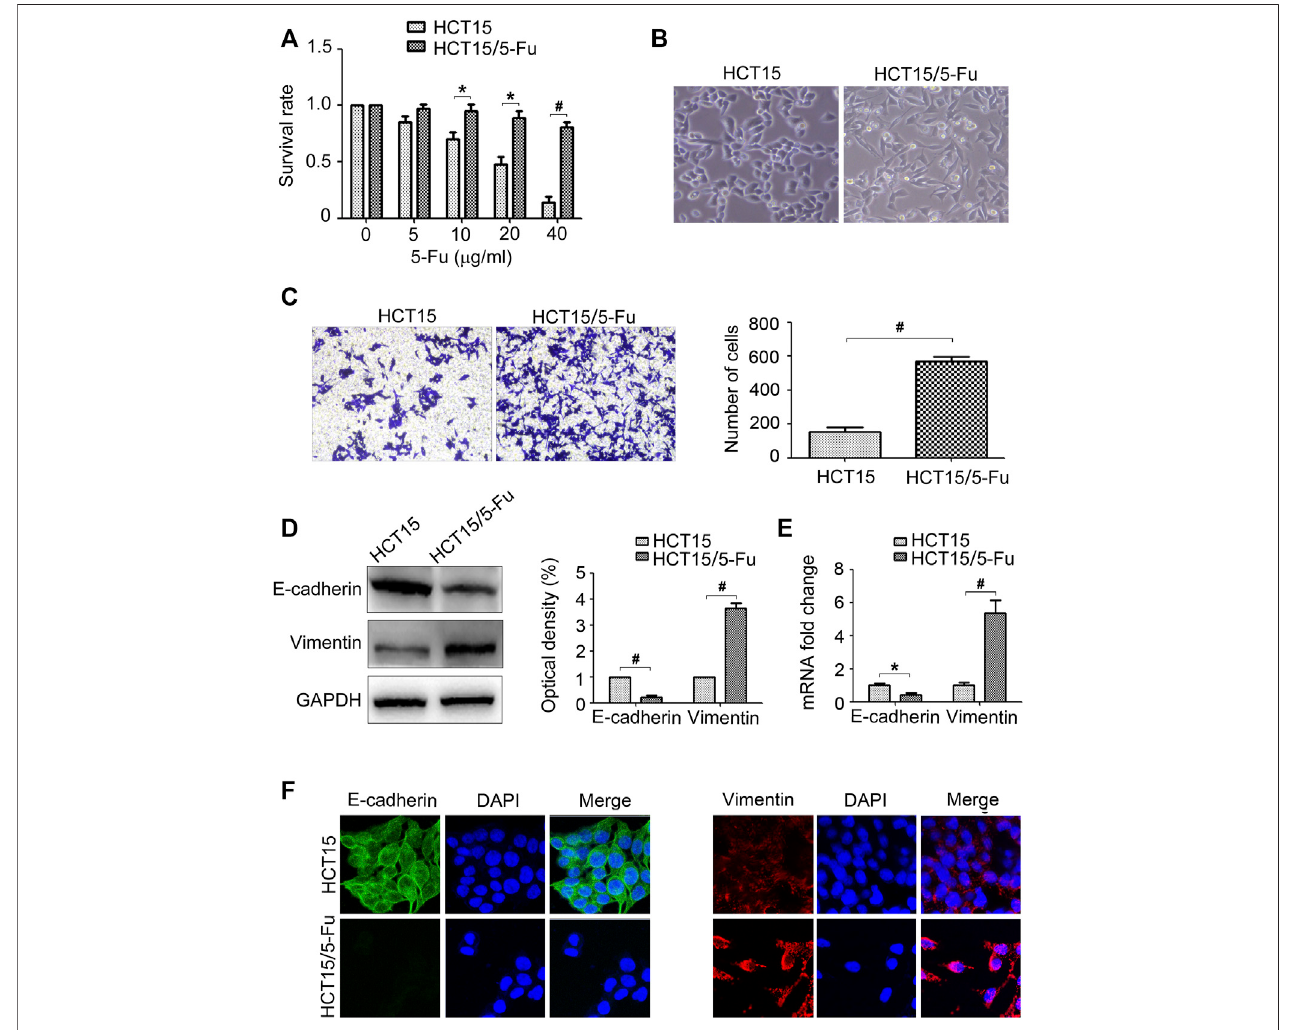
FIGURE 1 | 5-Fu resistant CRC cells acquire EMT phenotype. (A) HCT15 and HCT15/5-Fu cells were treated with increasing concentrations of 5-Fu for 48 h. CCK8 assay was used to quantify the viable cells. (B) Morphology of HCT15 and HCT15/5-Fu cells. (C) Transwell assay was performed to measure the migration of HCT15 and HCT15/5-Fu cells. (D,E) The protein and mRNA expression of E-cadherin and Vimentin in HCT15 and HCT15/5-Fu cells were examined by WB and RT- PCR, respectively. (F) The expression and cellular localization of E-cadherin and Vimentin were detected by IF staining. Nuclei were visualized with DAPI